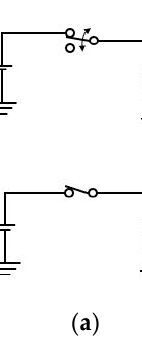
Figure 3. SWD discharge set-ups for: ( a ) one Li-Ion cell in pulsed and continuous mode ( b ) two Li-Ion cells in switched and parallel mode.